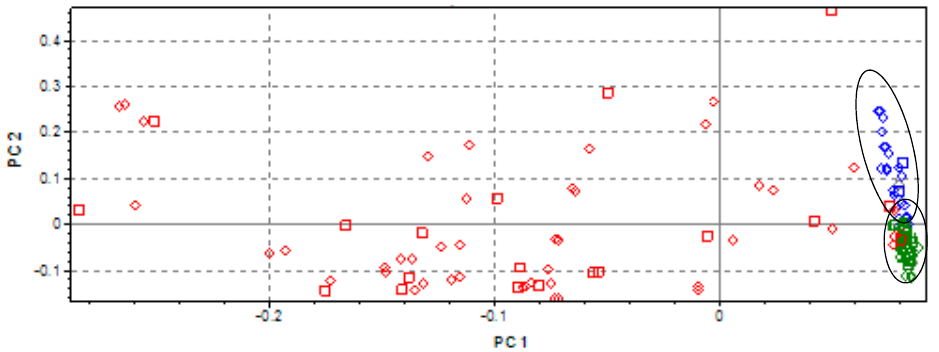
Figure 3. Principal component 2 (PC2) vs. PC1 plot for classification of soils samples based on Fourier transform-(FT) NIR spectra: WS (red); DS (green); GSS (blue). Along the PC1, which explains 76.22% of the variance, samples are grouped based on moisture content, showing the greatest relevance of this variable. Equally interesting, inside the DS group, a separated sub-cluster corresponding to only dried (blue) and GSS (green) samples along PC2 (19.78% of variance explained) can be clearly recognized. Spectra were surely influenced by the homogeneity of particle size, but as a second-priority